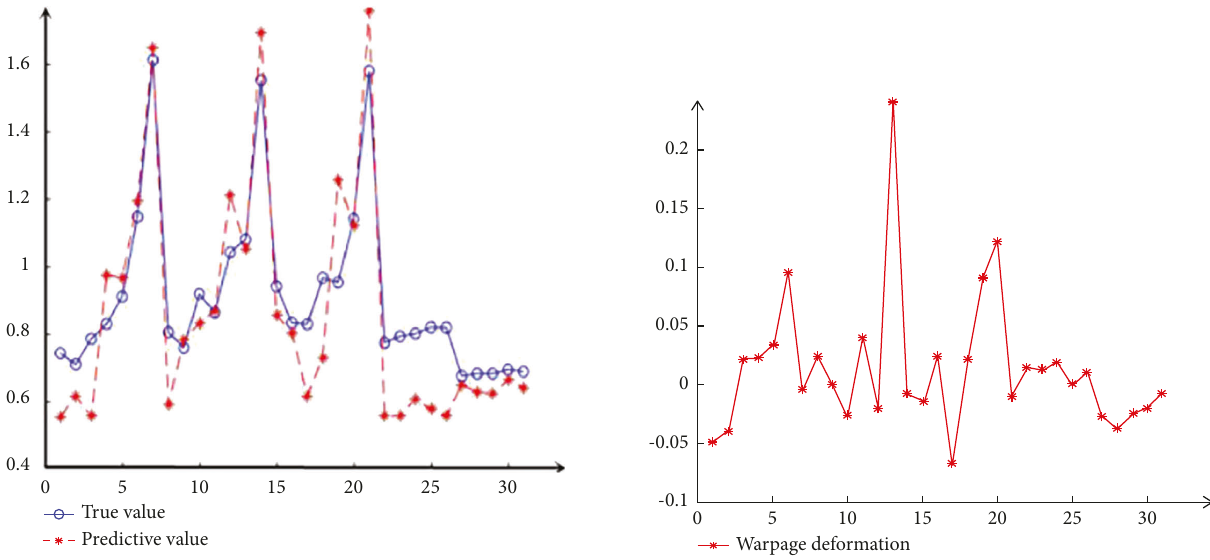
Figure 21: Warpage prediction result diagram.